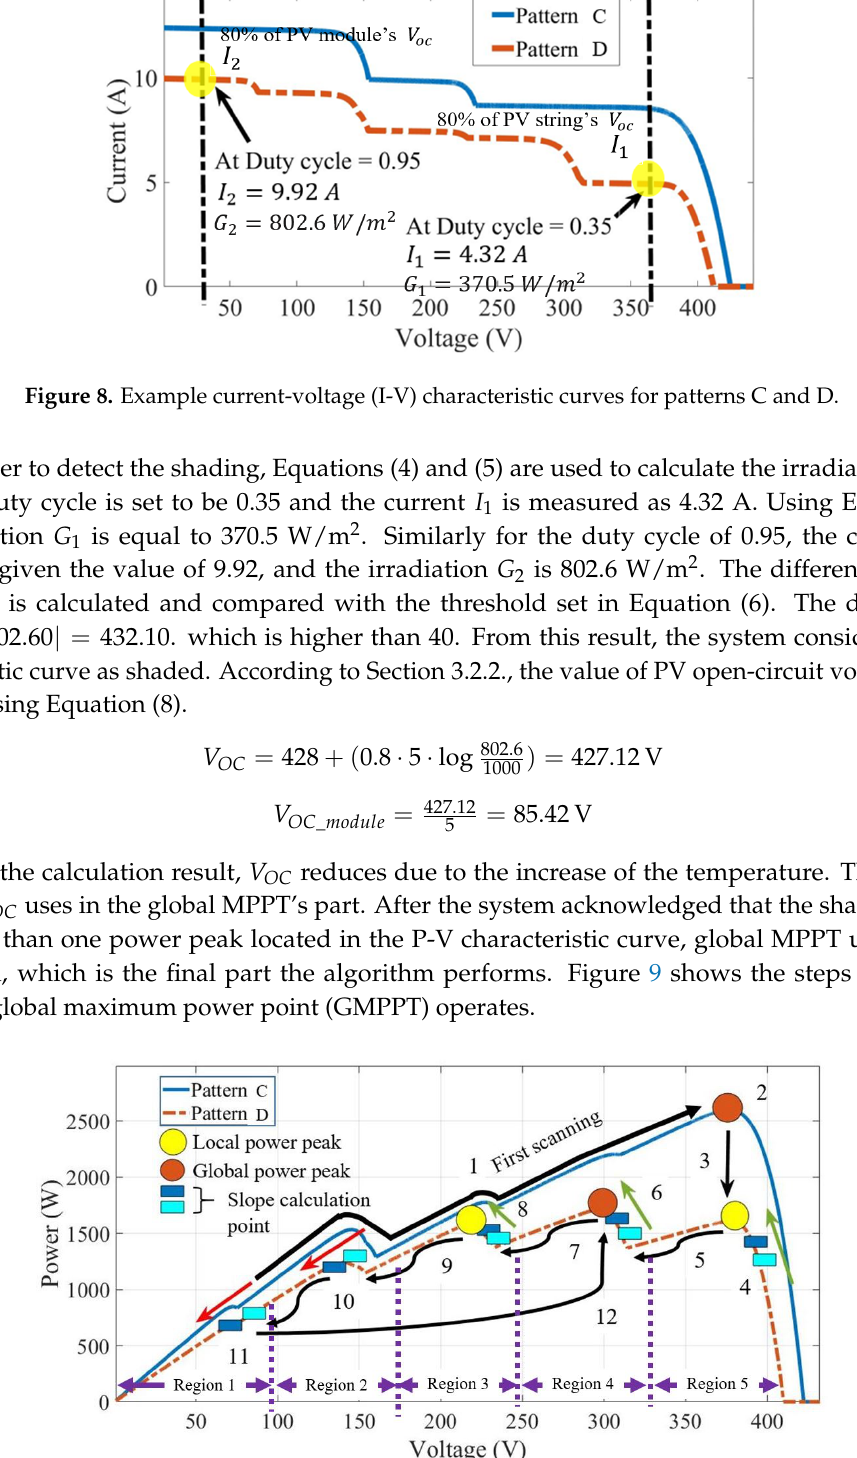
Figure 9. Example of P-V characteristic curves for patterns C and